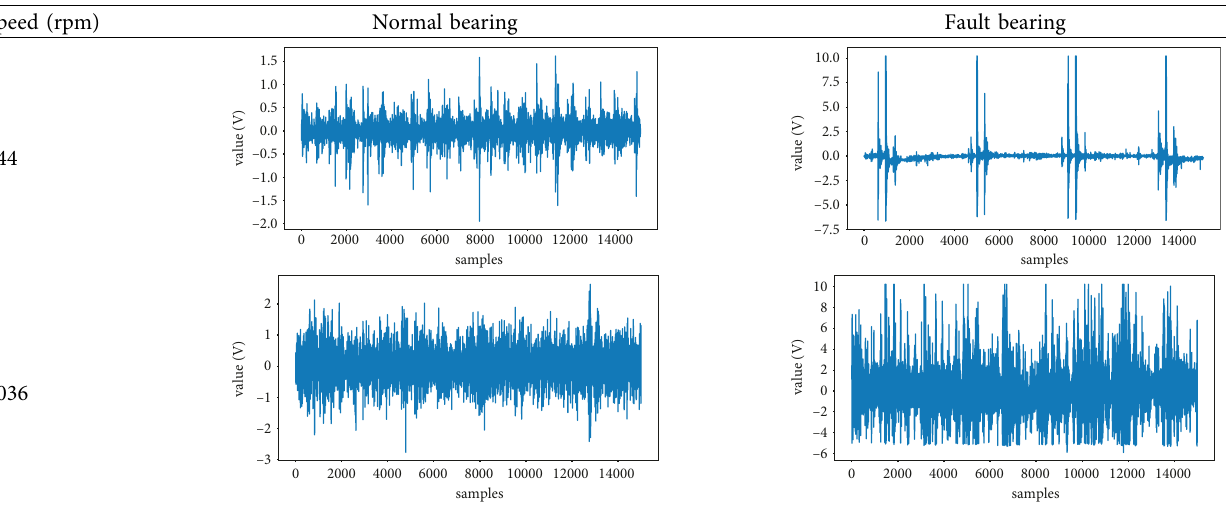
Table 5: Time domain diagram of vertical acceleration